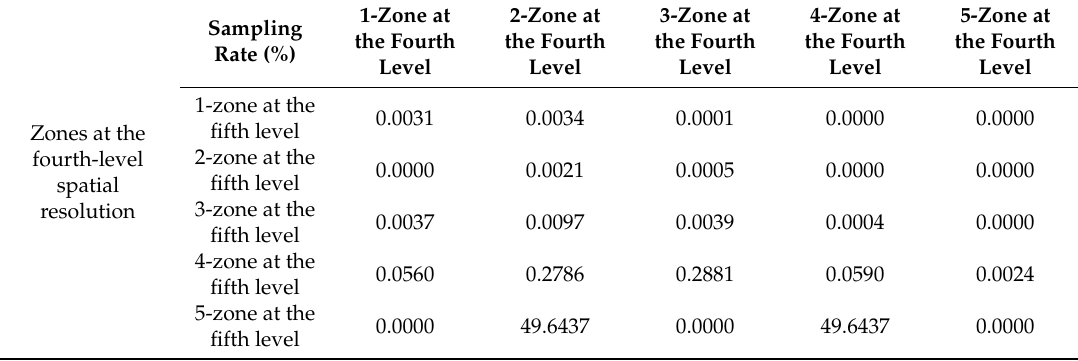
Table 2. Sampling rate of each zone at the fourth-level spatial resolution (54-m).